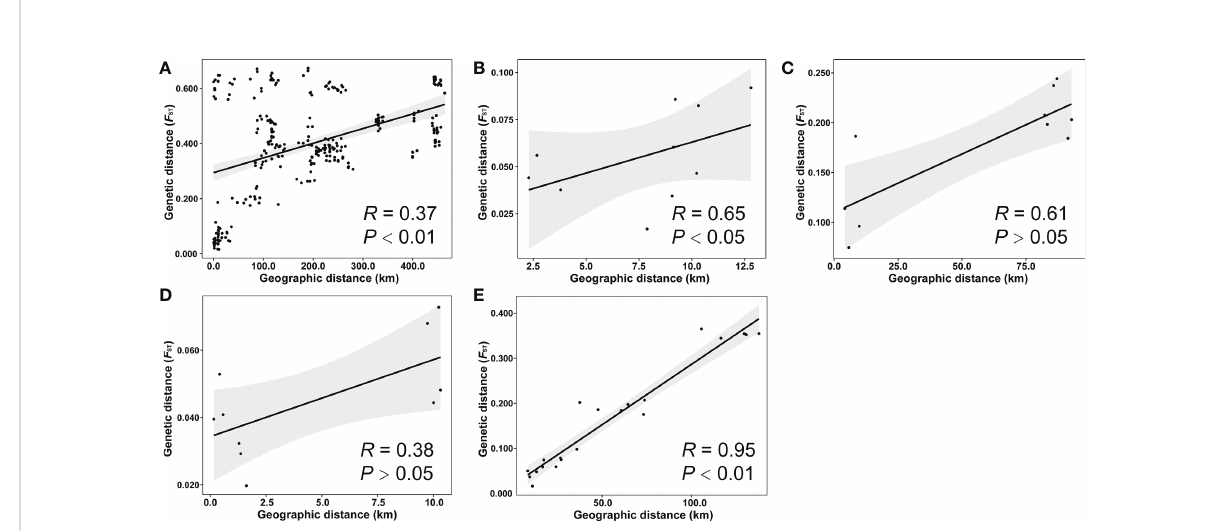
FIGURE 4 Isolation by distance analysis. Mantel test of the relationship between the genetic and geographic distances among the 25 populations of all species (A) , fi ve populations of H microcephala (B) , fi ve populations of H incana (C) , fi ve populations of H vernonioides (D) , and seven populations of H impressinervia (E)